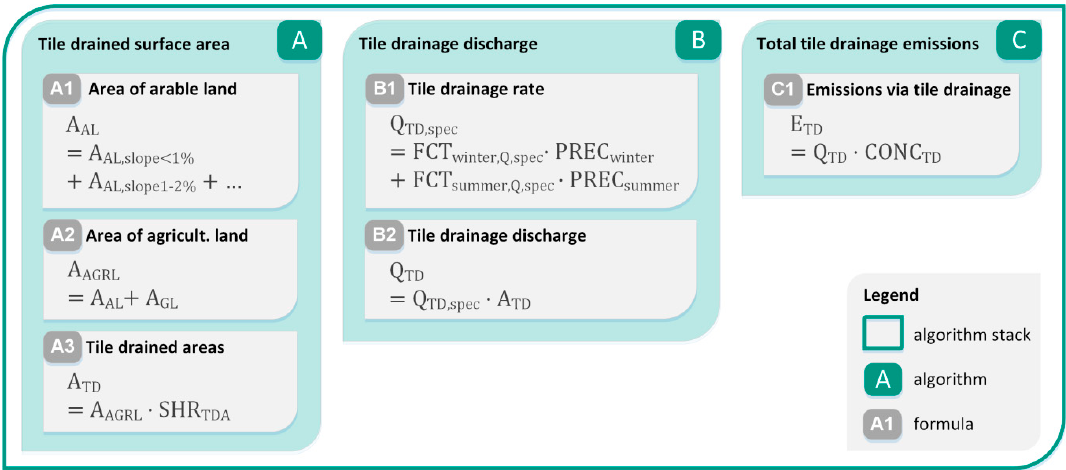
Figure 4. Example of the hierarchic implementation of the modeling approaches in MoRE. A: